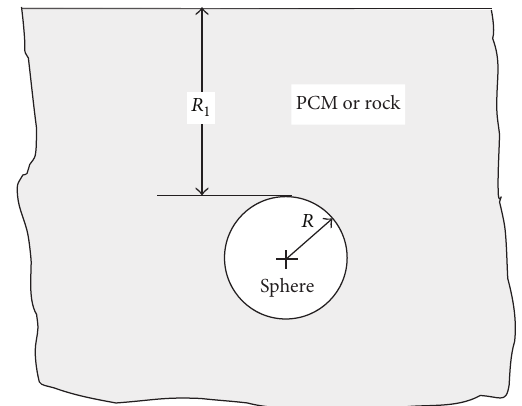
Figure 2: Schematic of sphere of radius 𝑅 buried in the PCM (or